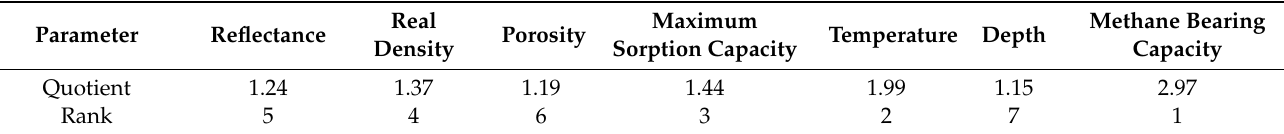
Table 2. Analysis of the neural network sensitivity for prediction of the average methane seam pressure.